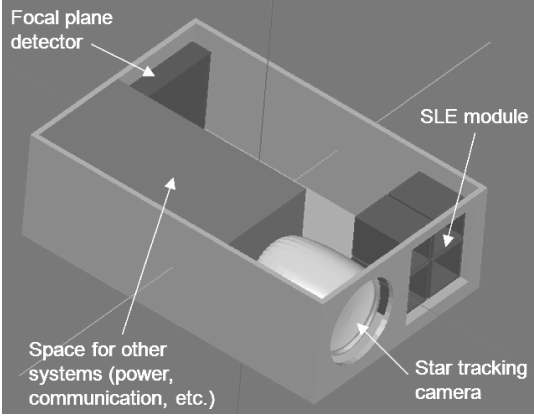
Fig. 1. Concept of the